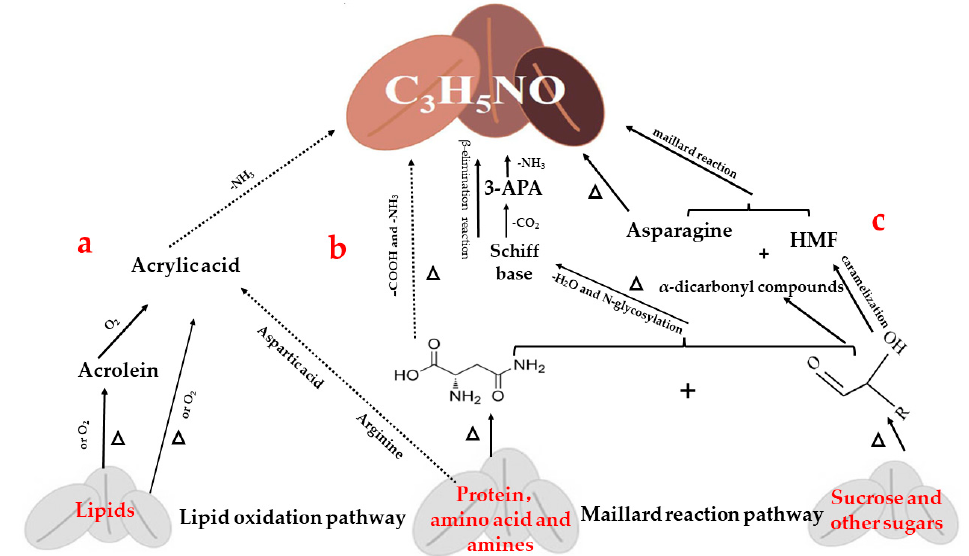
Figure 1 . Potential pathways of acrylamide formation during co ff ee processing. ( a ) Lipid oxidation Figure 1. Potential pathways of acrylamide formation during coffee processing. (a) Lipid oxidation pathways; ( b ) Protein and amino acid degradation pathways; ( c ) Maillard reaction pathway. pathways; (b) Protein and amino acid degradation pathways; (c) Maillard reaction